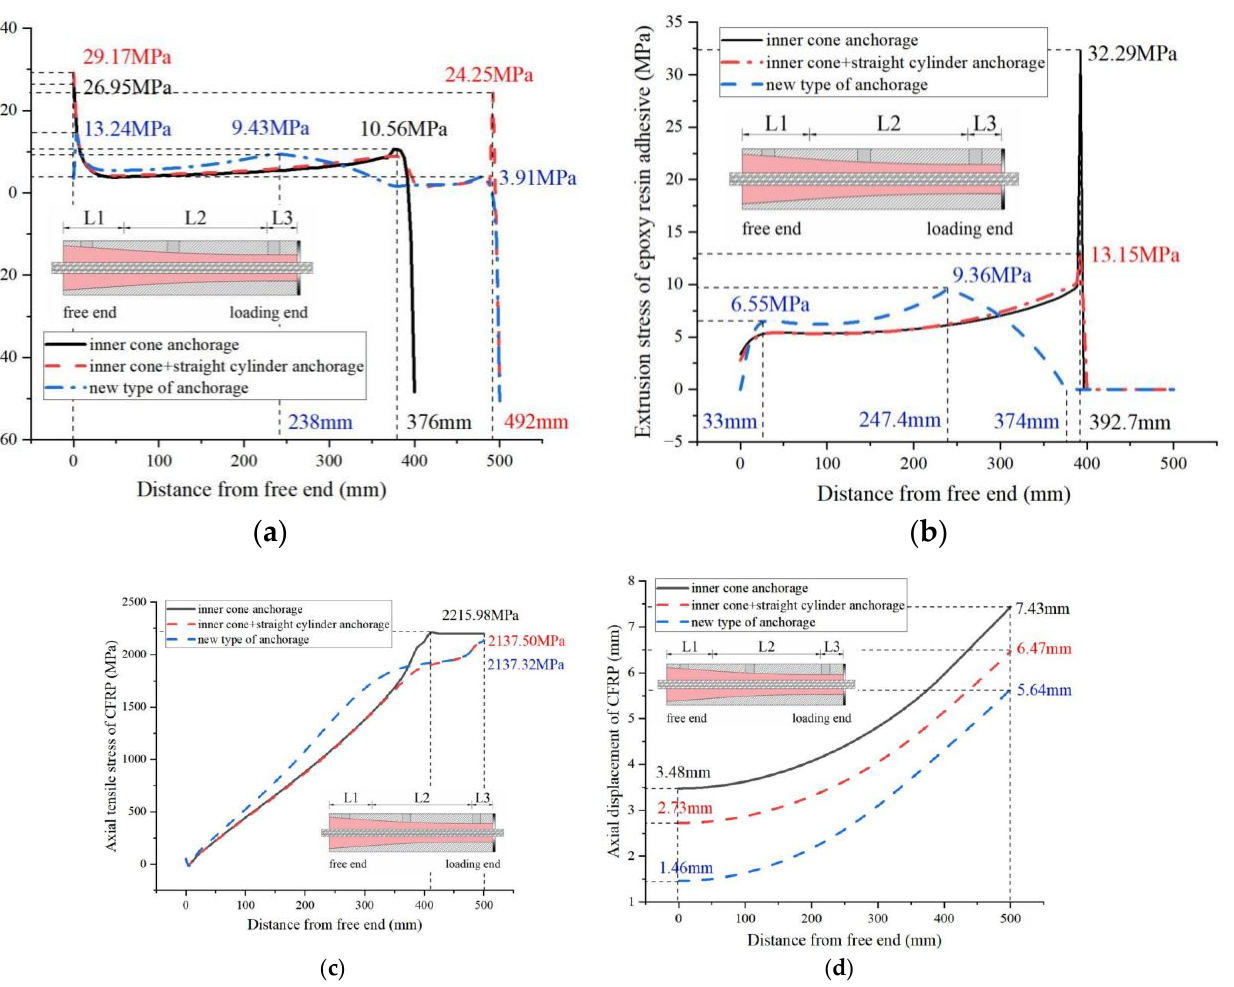
Figure 9. Mechanical performance comparison of three anchorages: ( a ) radical compressive stress of CFRP; ( b ) extrusion stress of epoxy resin adhesive; ( c ) axial tensile stress of CFRP; ( d ) axial displacement of CFRP.